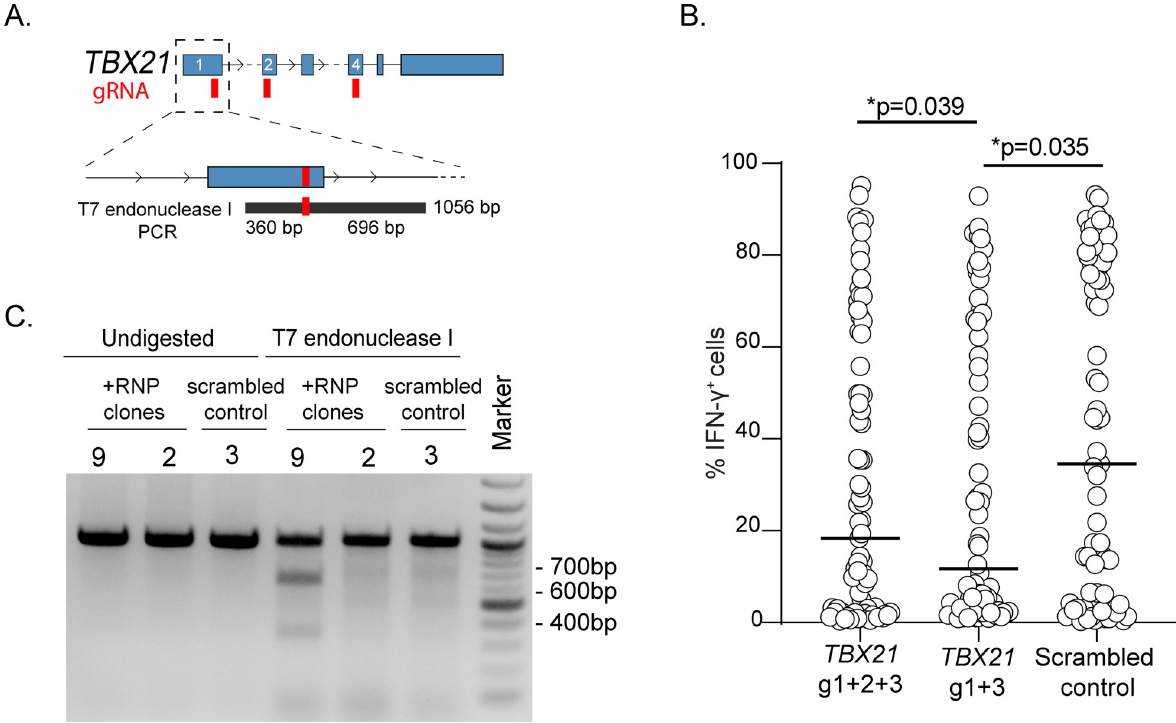
Fig 5. Deletion of the TBX21 gene in primary human T lymphocytes and functional analysis. (A) Schematic representation of the TBX21 gene with indicated the location of the gRNAs and PCR products. (B) After single cell-cloning and expansion, clones transfected with gRNAs against TBX21 or scrambled control oligonucleotides were stimulated with PMA and ionomycin and IFN- γ expression was measured by intracellular staining. Median ± SD. Each dot represents one individual clone (at least n = 72 clones). Mann-Whitney test. (C) Example of T7 endonuclease I digestion of one control clone and one modified clone (representative of n = 21 clones